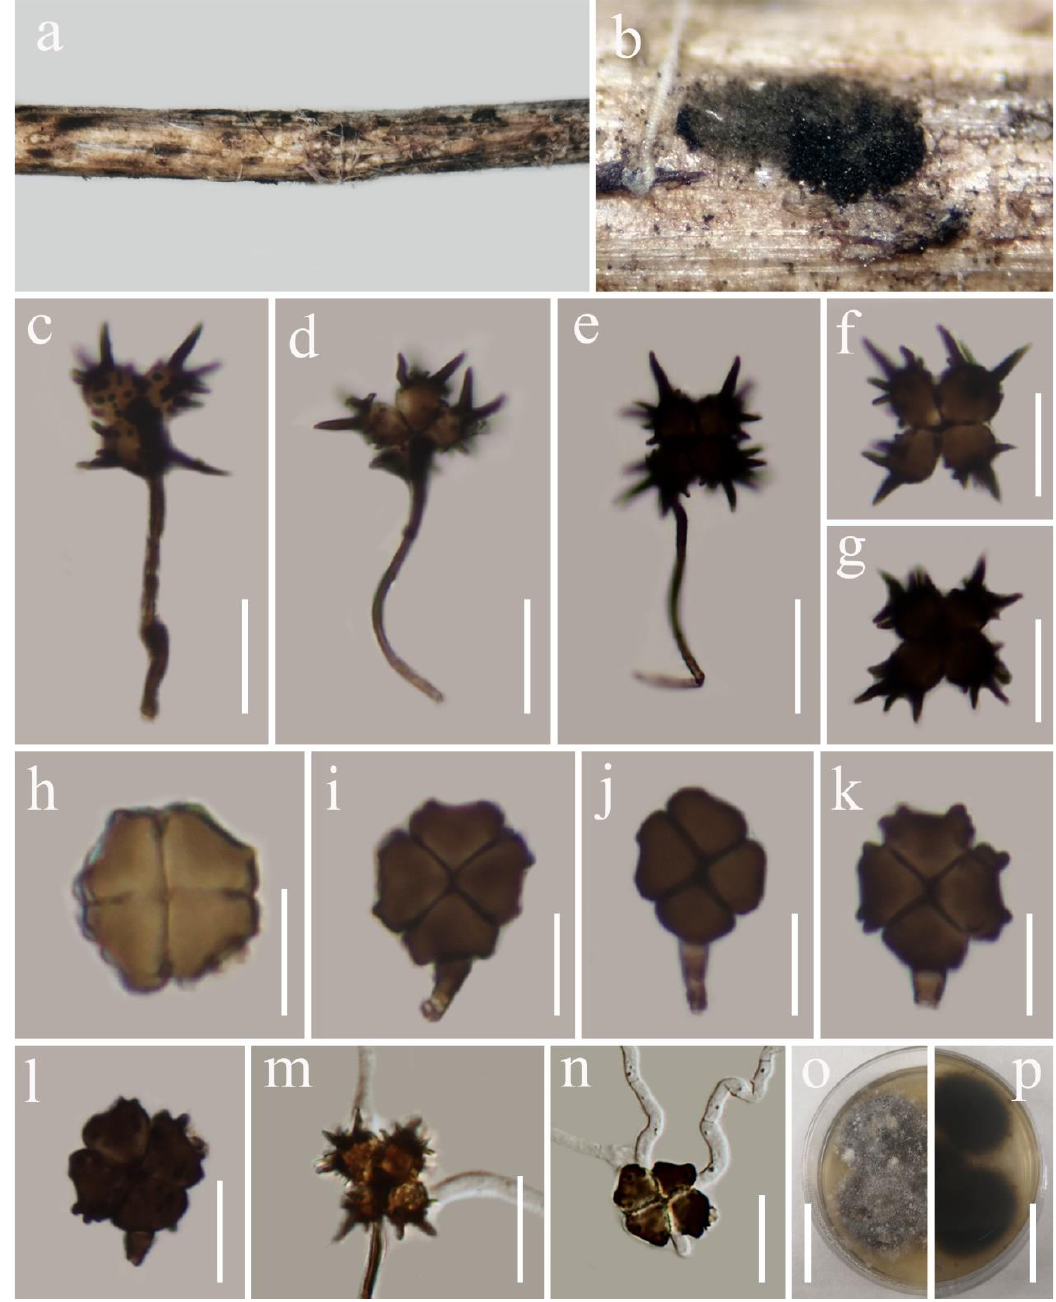
Figure 8. Spegazzinia jinghaensis (HKAS 122787 , holotype). ( a , b ) Fungal colonies on the host surface;